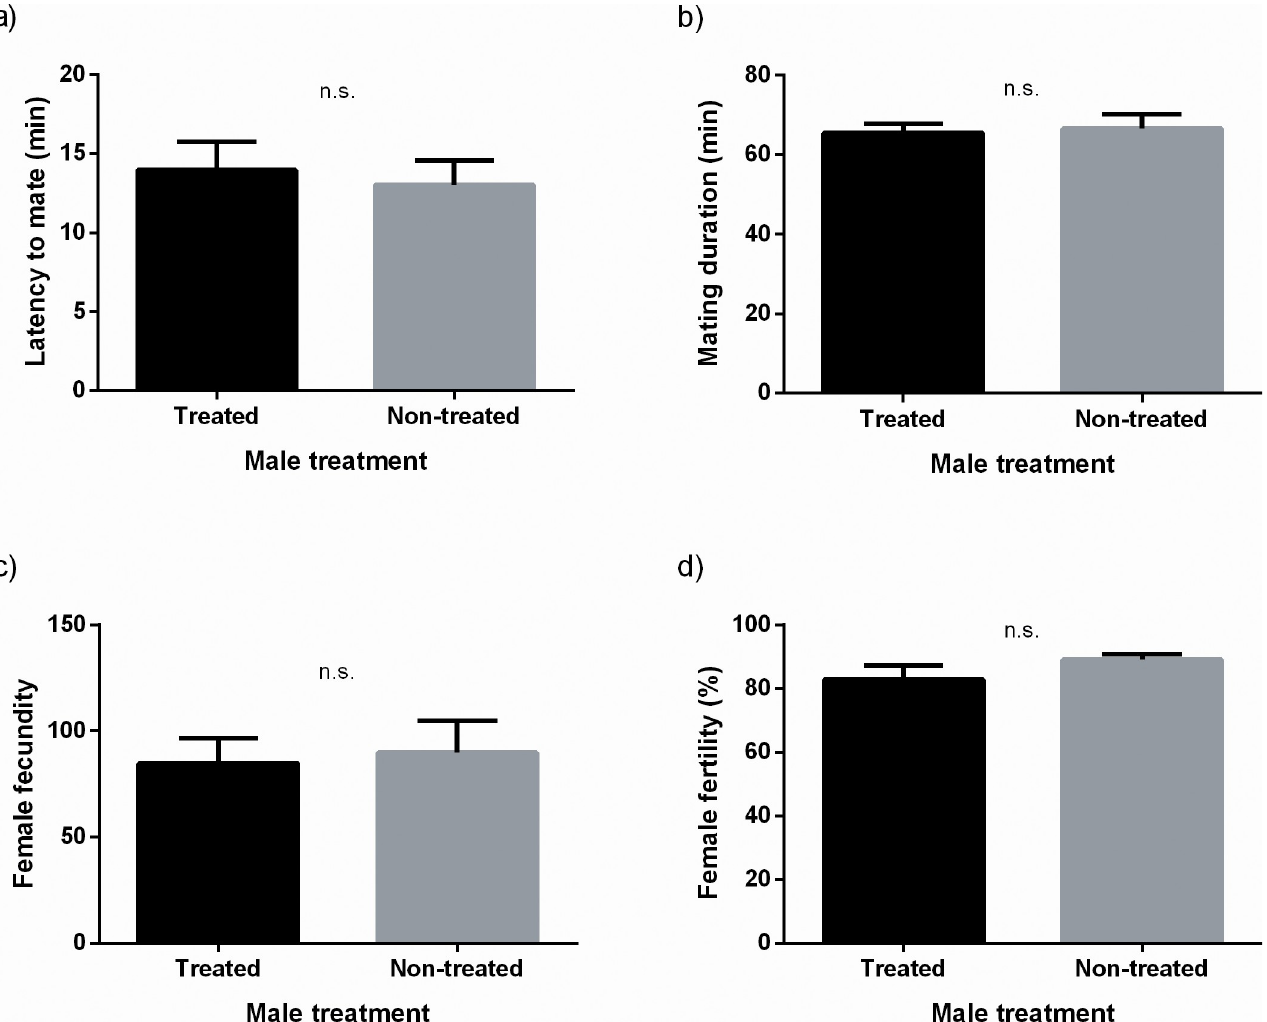
Fig 5. Latency to mate (A), mating duration (B), fecundity ( per capita ) (C) and fertility (D) for females mated to males treated or non-treated with methoprene. Bars represent mean values and SE for each variable. n.s. indicates non statistically significant differences between mean values after independent